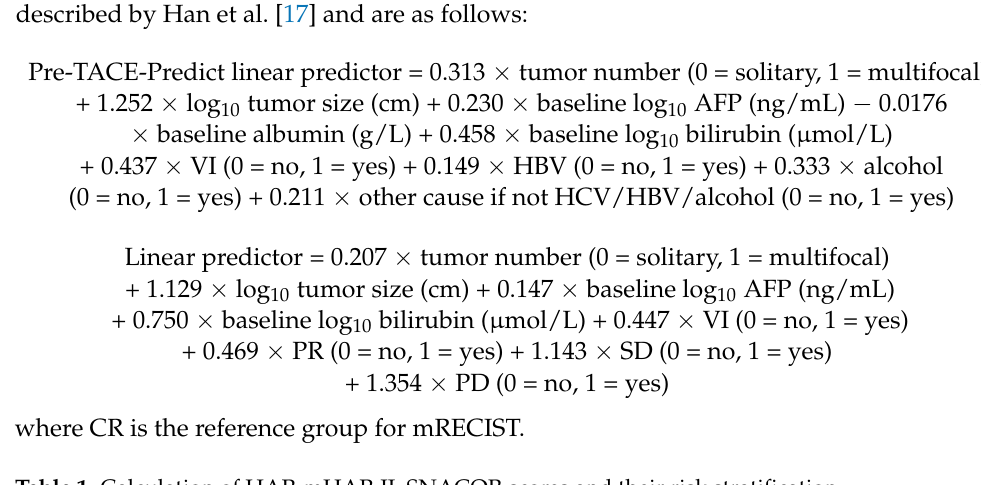
Table 1. Calculation of HAP, mHAP-II, SNACOR scores and their risk stratification. Models Based upon Only Pre-Treatment Factors Variables HAP score * mHAP-II score * Variables SNACOR score *